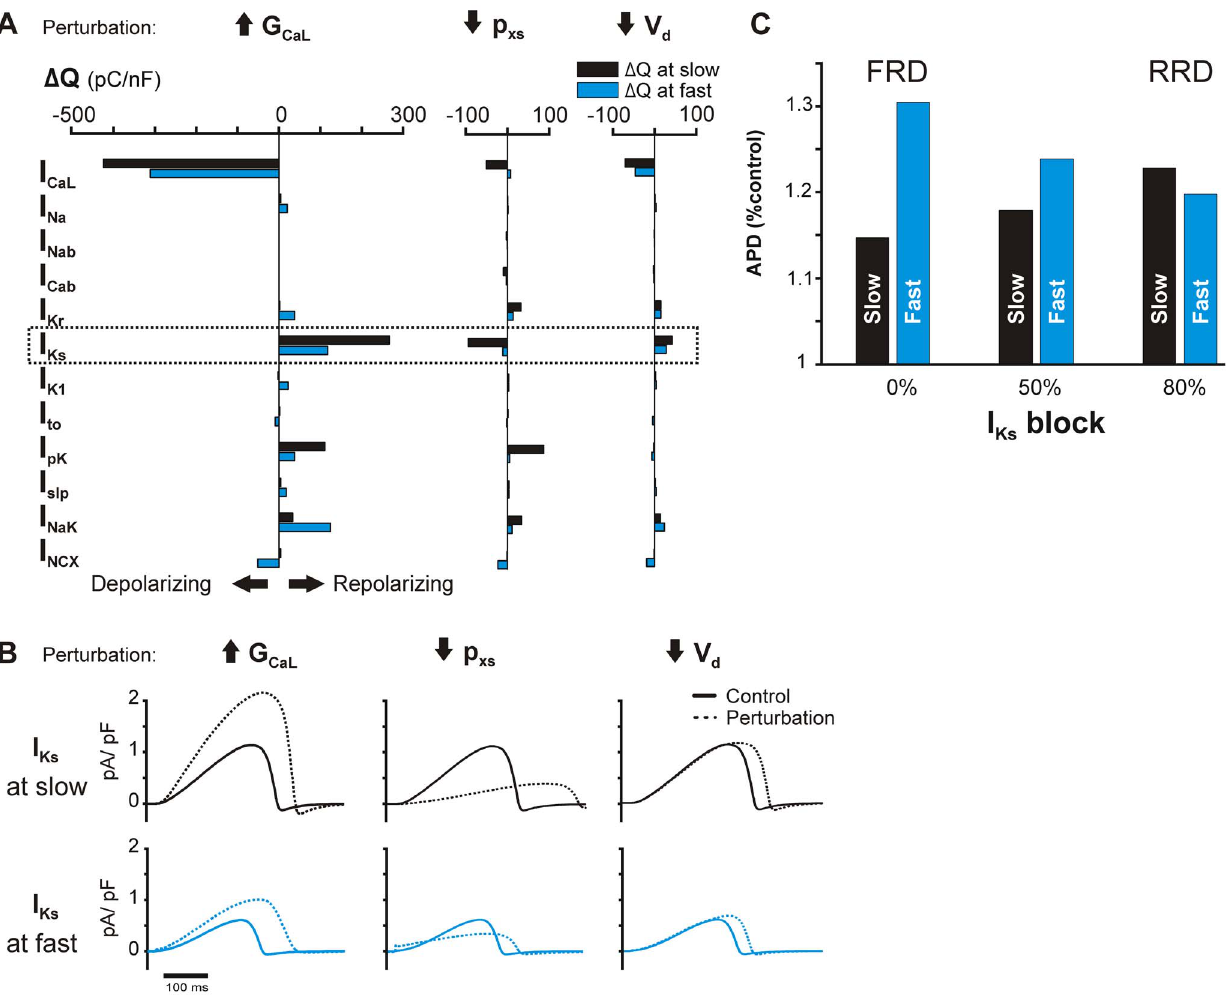
Figure 8. Ionic current changes underlying rate dependence of perturbations in the TP06 epicardial model. ( A ) D Q analysis of major ionic currents under 3 perturbations: increase in L-type Ca 2 + channel maximal conductance, G CaL (271% of baseline, a FRD perturbation), slowed activation of the slow delayed rectifier K + channel (38% of baseline p xs , a RRD perturbation), and a negative shift in the voltage dependence of L-type Ca 2 + activation (5 mV decrease in V d , a NRD perturbation). D Q quantifies the change in current flux with the perturbation, and is calculated at fast and slow pacing. ( B ) Slow delayed rectifier current (I Ks ) under each perturbation, at fast and slow pacing. ( C ) APD under increased G CaL (271% baseline) and varying degrees of I Ks block. The APD rate dependence of I CaL enhancement is reversed by simultaneous block of I Ks, as predicted by D Q analysis ( A ).